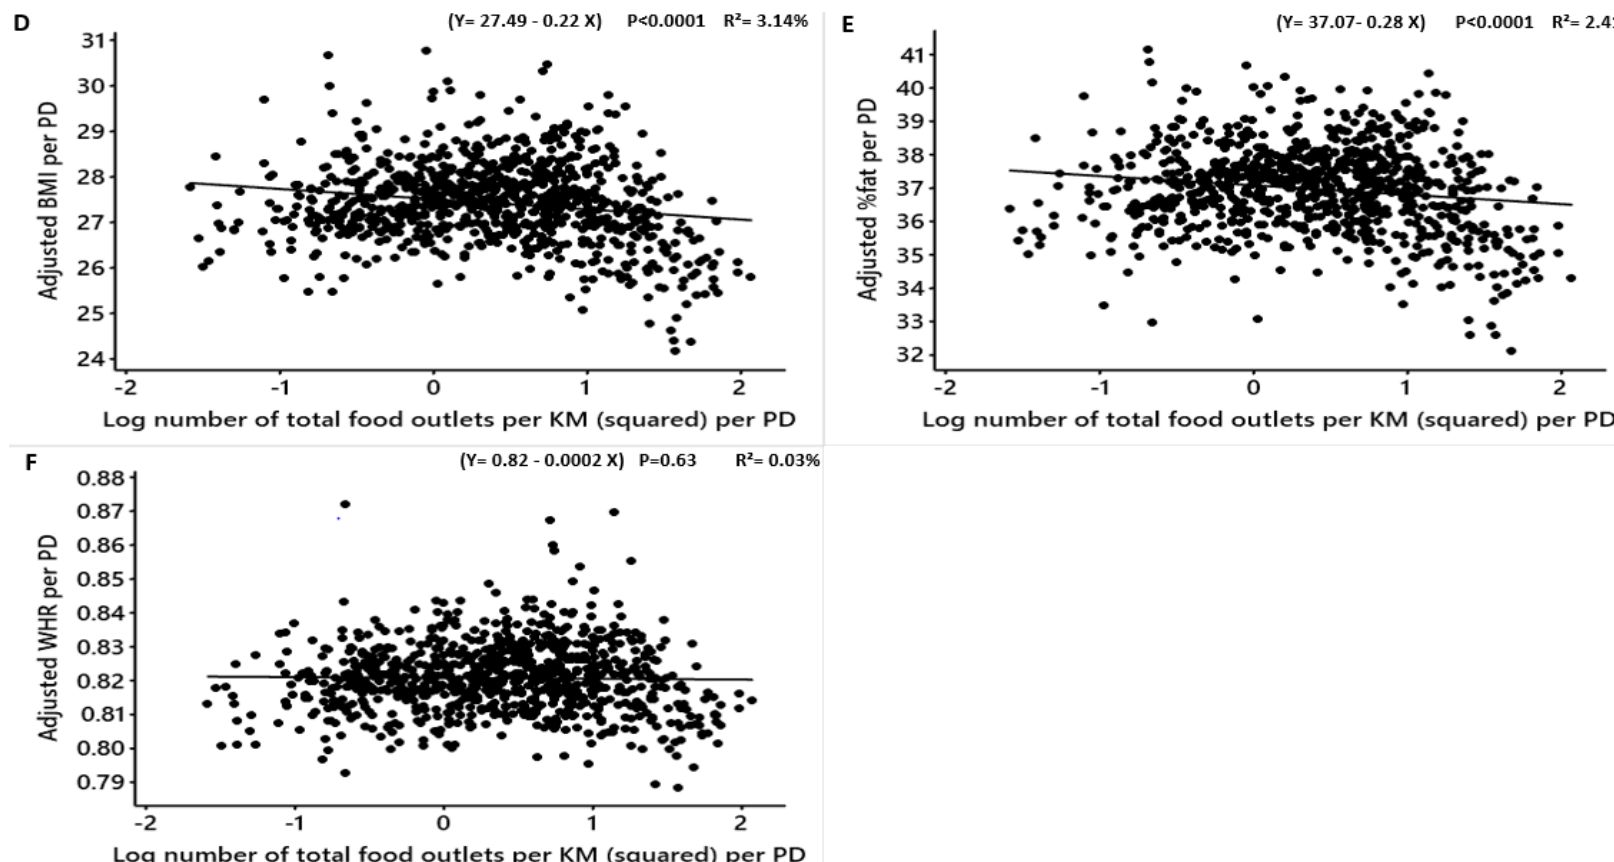
Figure A2. Females: Linear regression analysis of the association between log number of food outlets per KM 2 per PD and adjusted obesity measures. Obesity measures adjusted for deprivation level per household, education, employment, ethnicity, household size, household income and age. BMI = Body Mass Index, WHR = Waist to Hip Ratio. Total food outlets = number of food outlets combined per kilometre squared per postcode